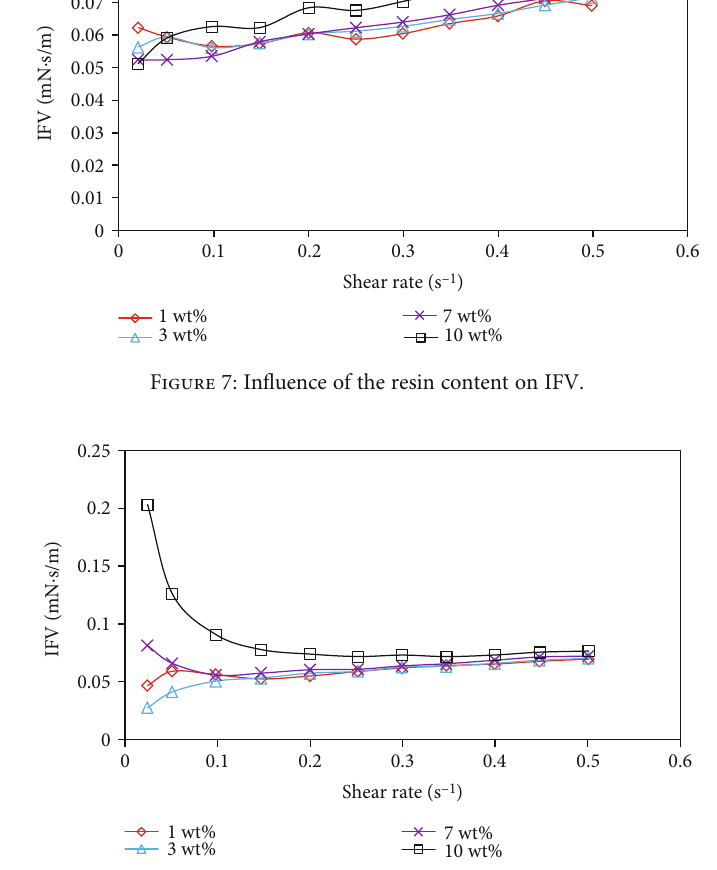
Figure 8: In fl uence of the wax content on IFV. Table 6: The water volume released from the emulsions obtained with di ff erent contents of asphaltene, resin, and wax.